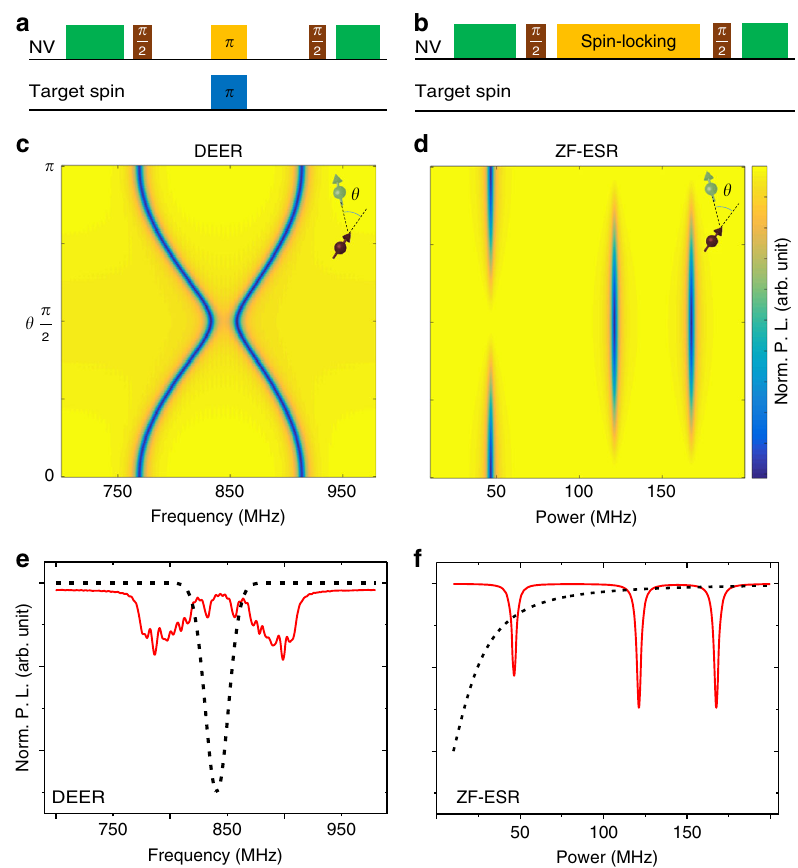
Fig. 4 Comparison between DEER method and ZF-ESR method. a Pulse sequence for DEER measurement. The frequency of the pulse applied on the target spin (blue box) is swept. b Pulse sequence for ZF-ESR measurement. The power of the driving pulse (orange box) is swept. c , d Simulated DEER and ZF- ESR spectra of differently oriented nitroxides. θ is the angle between the principal axis of the nitroxide and the N – V axis. The magnetic fi eld for DEER measurement is 300G with direction parallel to the N – V axis. The principal values of the hyper fi ne tensor are A xx = A yy = 23.2 MHz and A zz = 144.4 MHz. e , f Schematic diagram of the background signal. The red solid and dark dashed lines indicate the signal of the target spins and the background spins, respectively. Here, the target spins are 10 randomly oriented